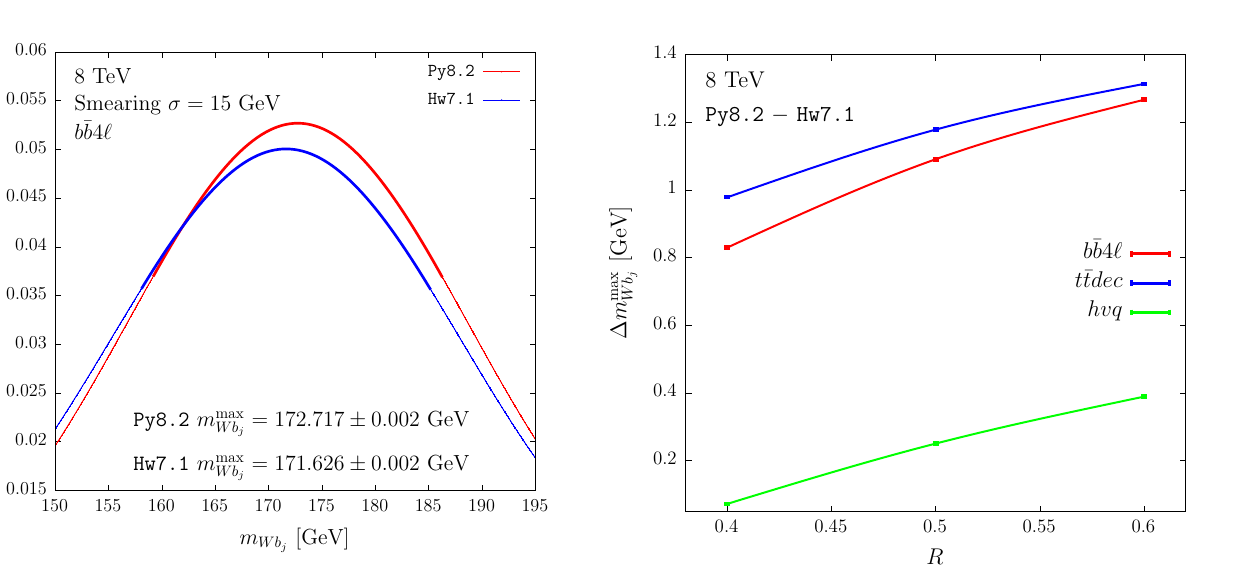
Fig. 14 Differences of m max between the Pythia8.2 and the Wb j Herwig7.1 showers, for the three generators, as a function of the jet radius